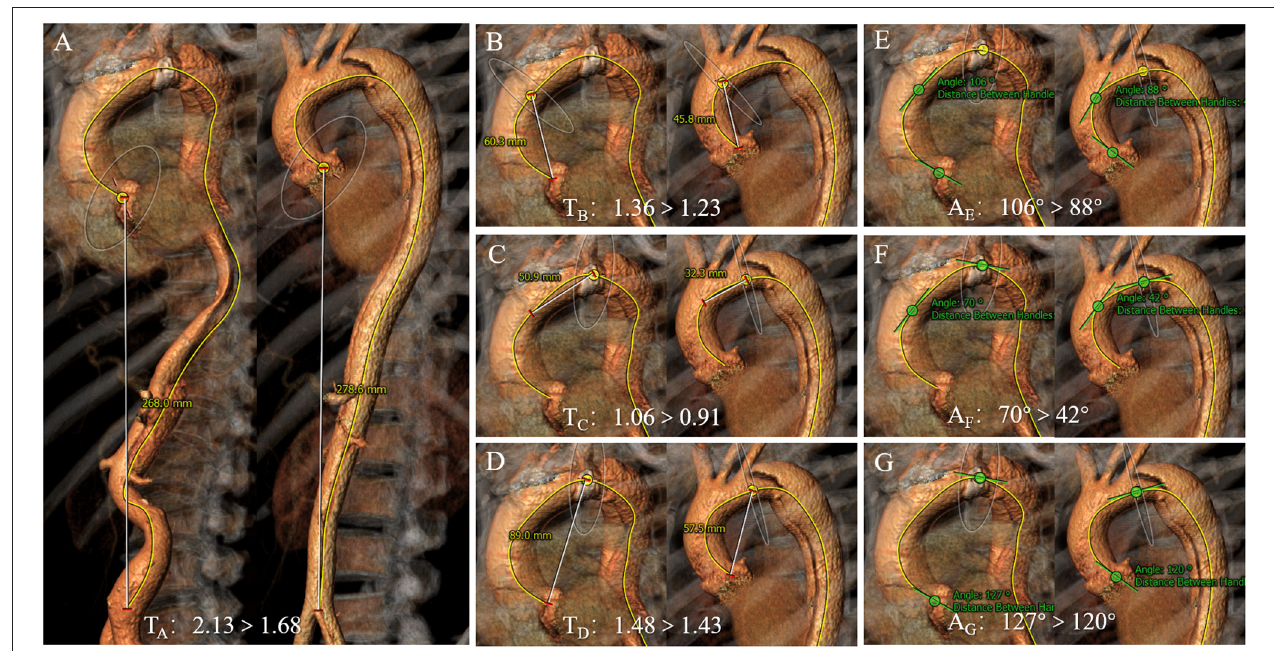
FIGURE 4 | Comparison of different aortic tortuosity and angulation in patients with acute type B aortic dissection (aTBAD). (A) High tortuosity (left aorta) vs. low tortuosity (right aorta) of the entire aorta. (B–D) High tortuosity (left row) vs. low tortuosity (right row) of the ascending aorta, aortic arch, and proximal aorta. (E–G) High angulation (left row) vs. low angulation (right row) of the ascending aorta, aortic arch, and proximal